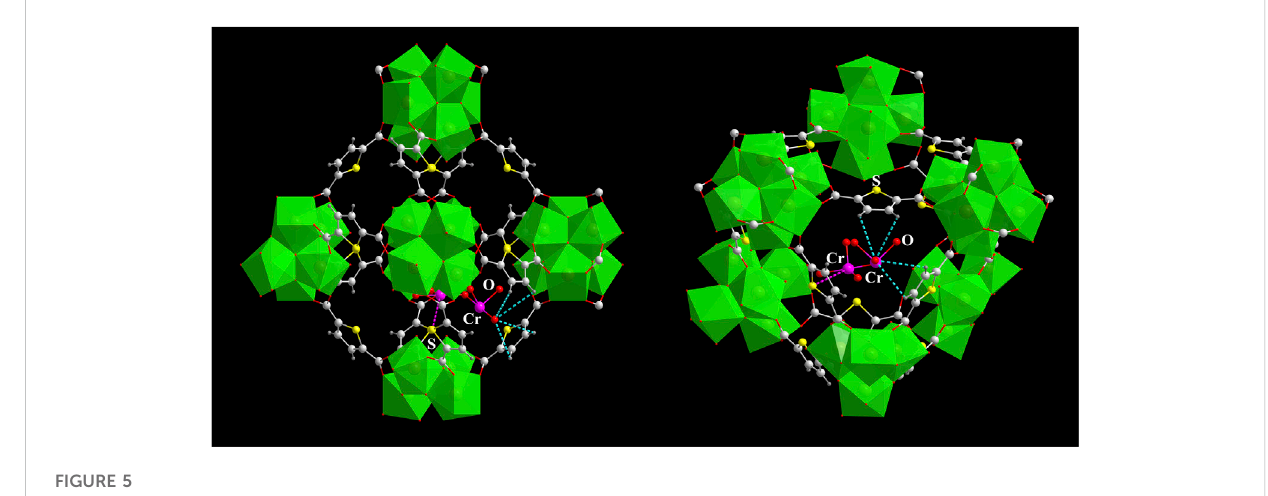
FIGURE 5 Interaction of the Cr(VI) ion and DUT-67